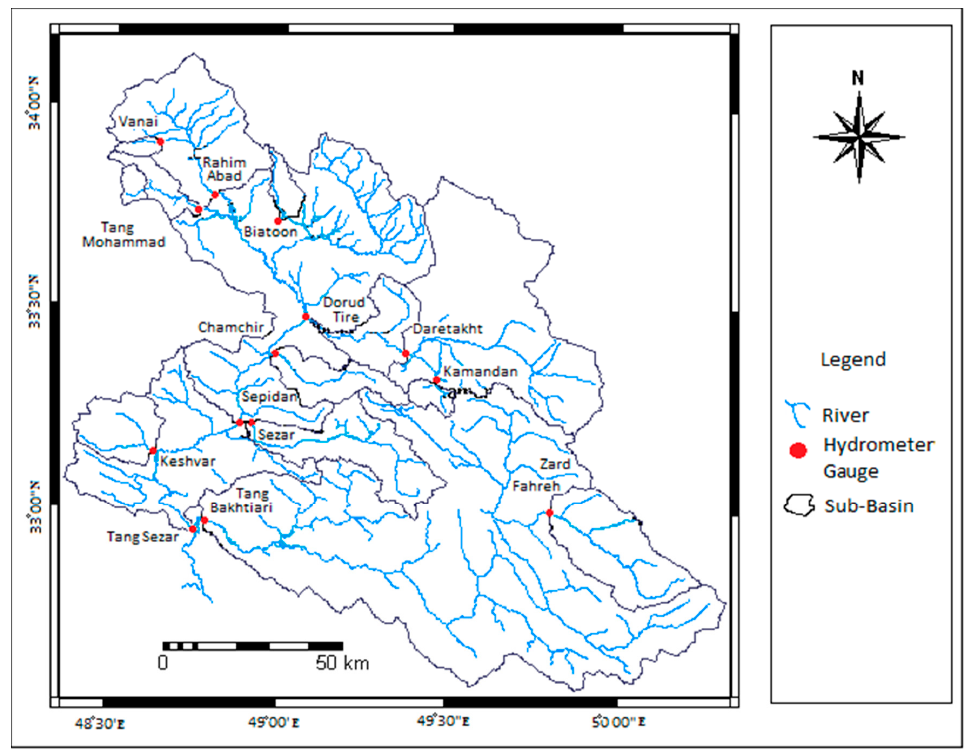
Figure 5. Selected hydrometric stations in Dez Basin.